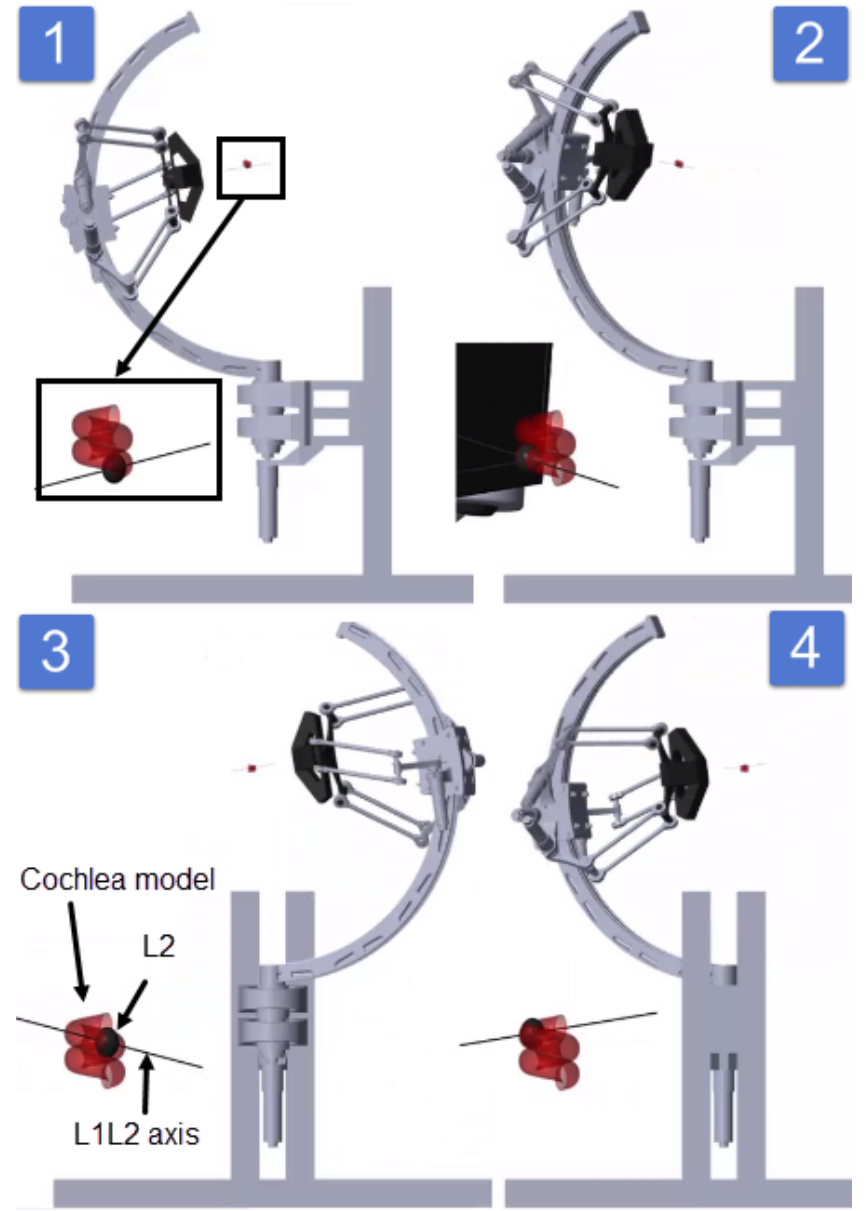
Figure 34. Snapshots (1–4) for the end effector travel through the